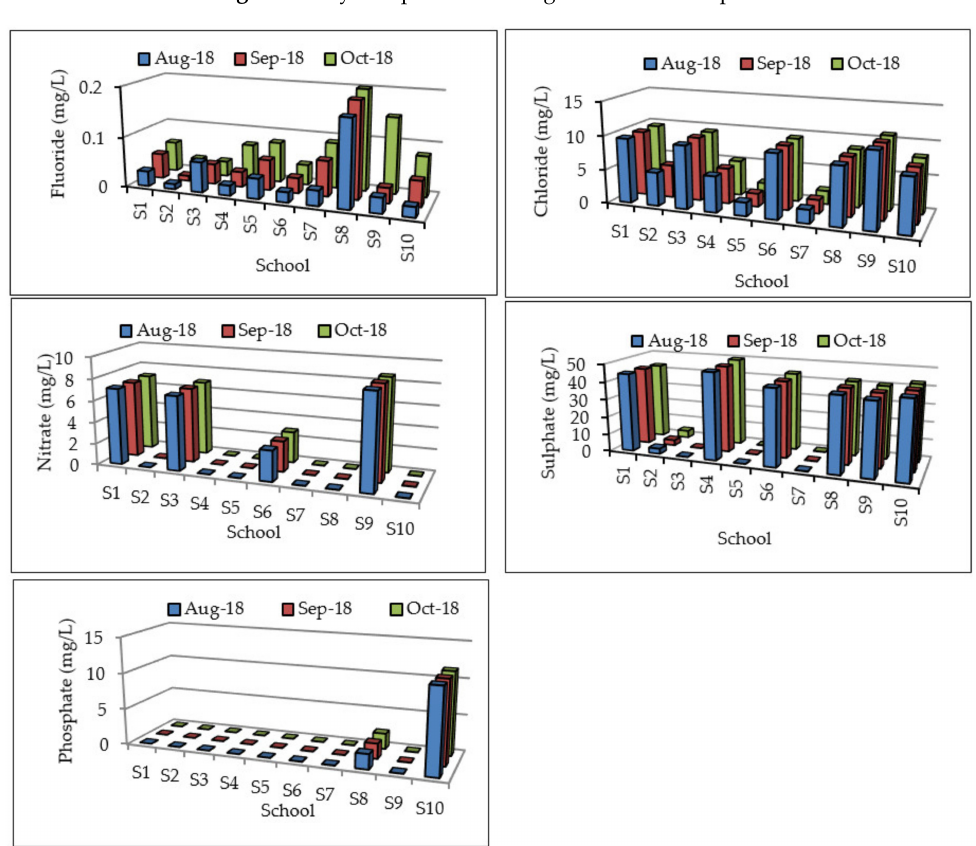
Figure 3. Fluoride, chloride, nitrate, sulphate, and phosphate concentrations (mg / L) in